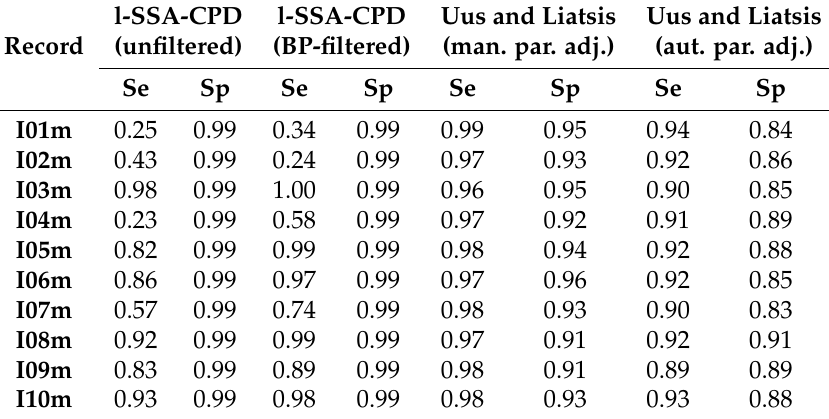
Table 4. Performance comparison of l-SSA-CPD (using D † 3 Uus and Liatsis (see [48], Table I) on INCART